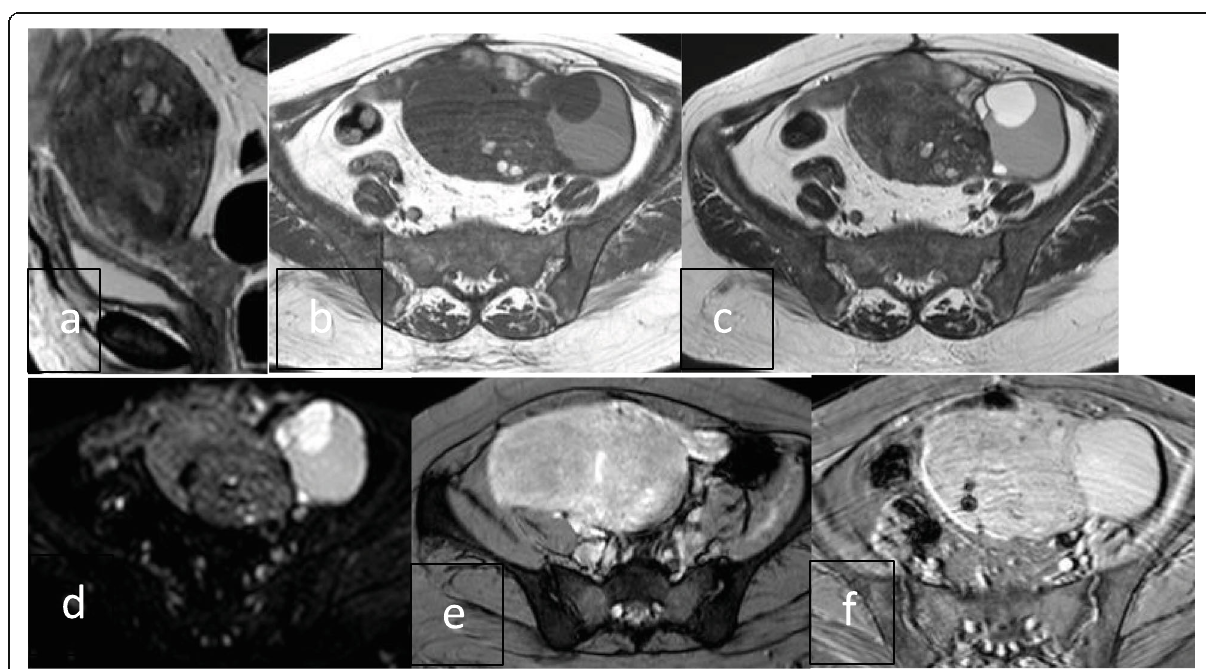
Fig. 3 ( a ) Sagittal T2 MRI showing diffuse thickening and irregularity of the posterior junctional zone. The posterior fundal myometrium is heterogeneous showing cystic changes bright in T1 and T2 ( b , c ). With diffusion restriction( d , e ); T2* revealed signal void punctate foci ( f ), suggesting adenomyosis. N.B: left adnexal cystic lesion showing facilitated diffusion. Histopathological diagnosis: focal adenomyosis and left peritoneal inclusion